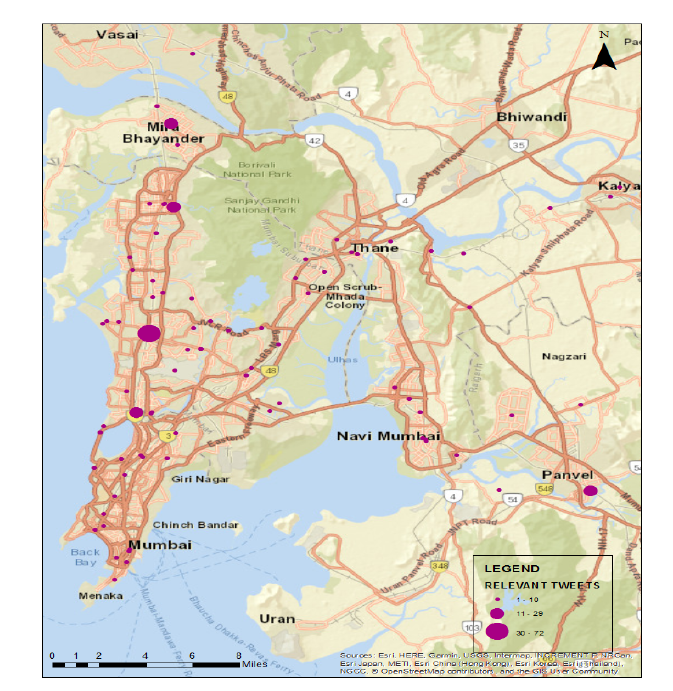
Figure 5. Locations of relevant tweet intensity.